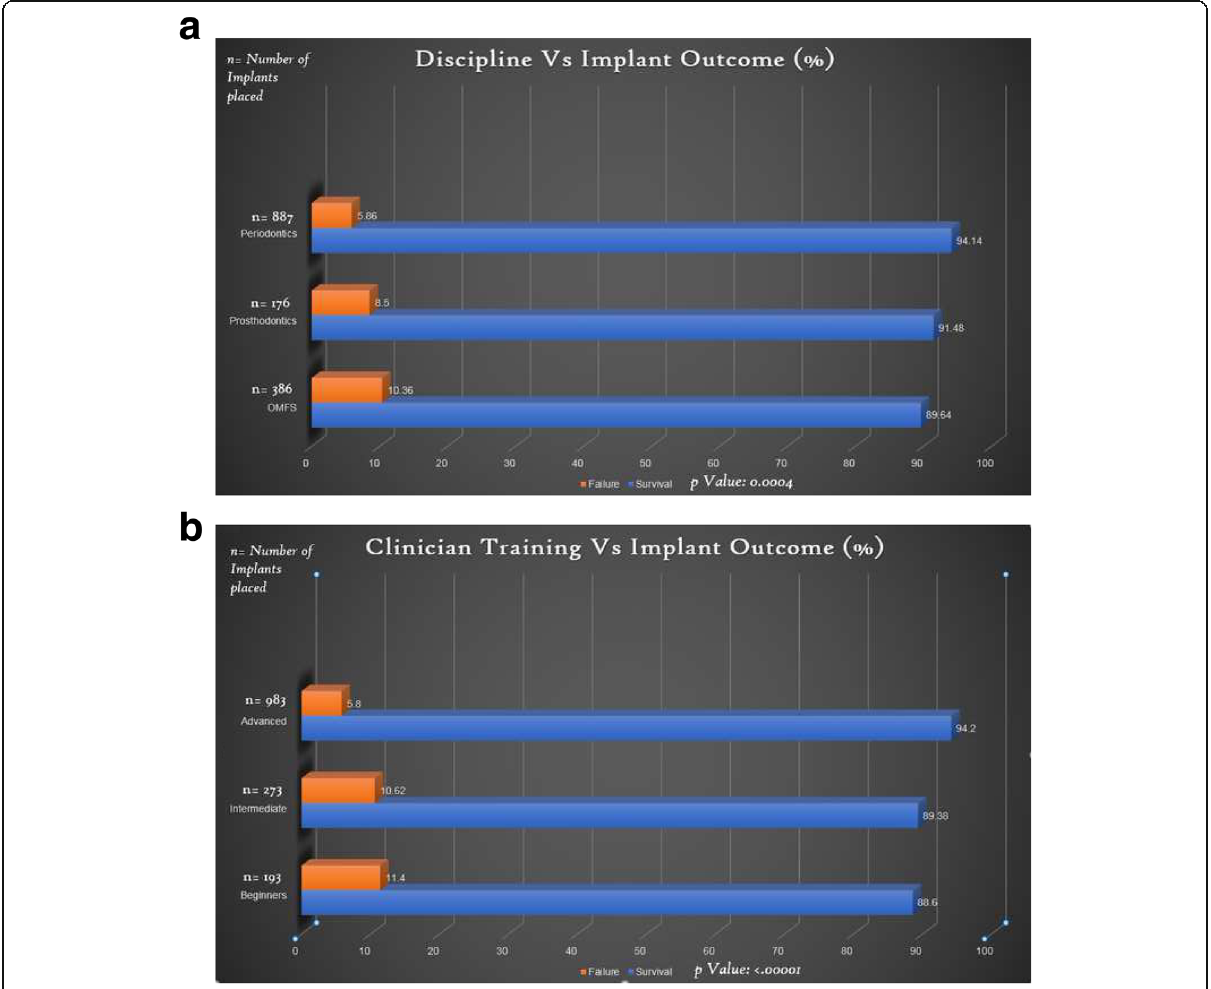
Fig. 1 a Distribution of dental implant outcome across various disciplines. b Distribution of dental implant outcome across various clinician training